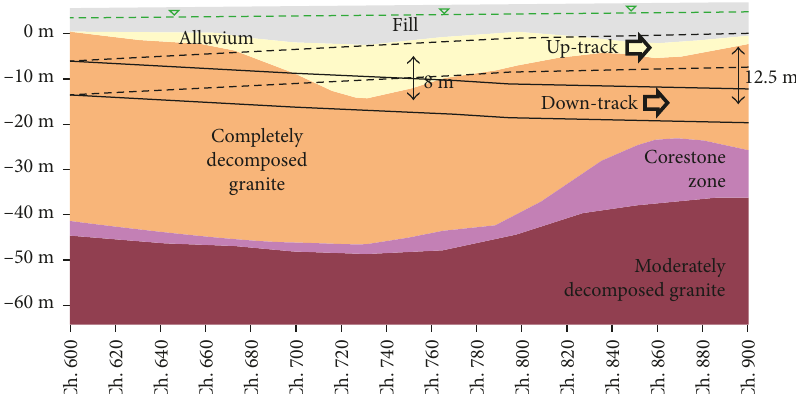
Figure 2: Longitudinal profile of the monitoring section.